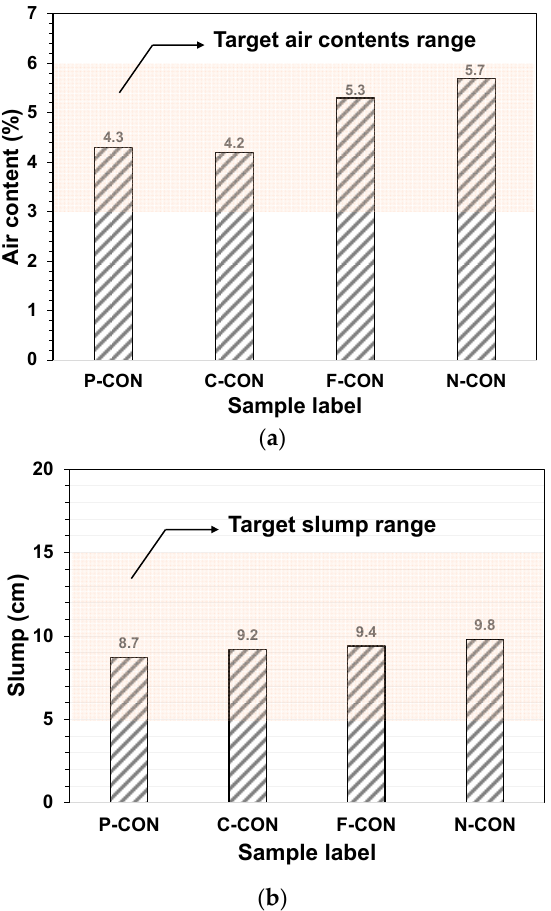
The compressive strength was 48 MPa for P-CON, but the CaO-activated GGBFS con- Figure 3. The test results: ( a ) air content and ( b ) slump of fresh concrete samples. cretes gained only about 10 to 30 MPa, significantly lower compressive strength than f cr .